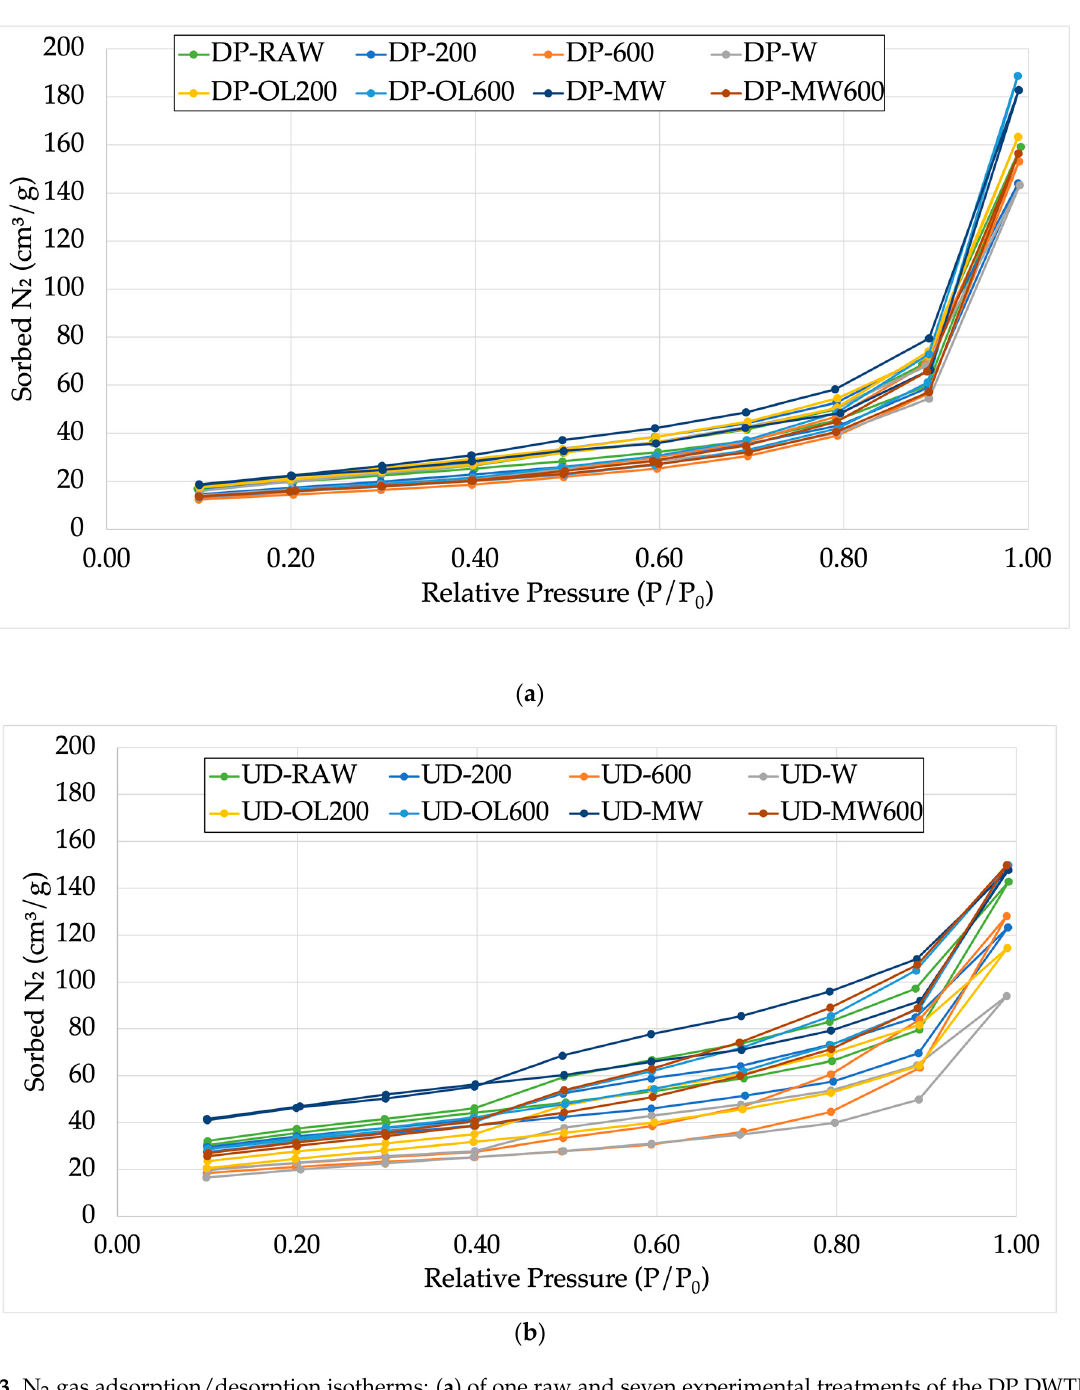
Figure 3. N 2 gas adsorption/desorption isotherms: ( a ) of one raw and seven experimental treatments of the DP DWTR; ( b ) of one raw and seven experimental treatments of the UD DWTR.